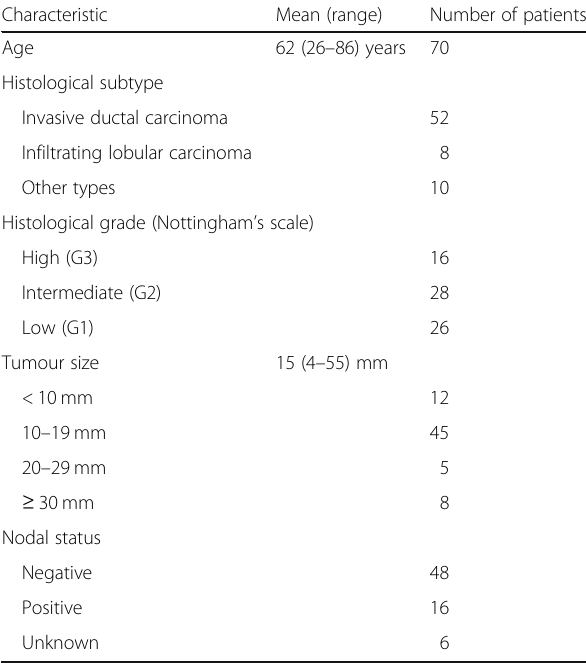
Table 1 Patients and tumour